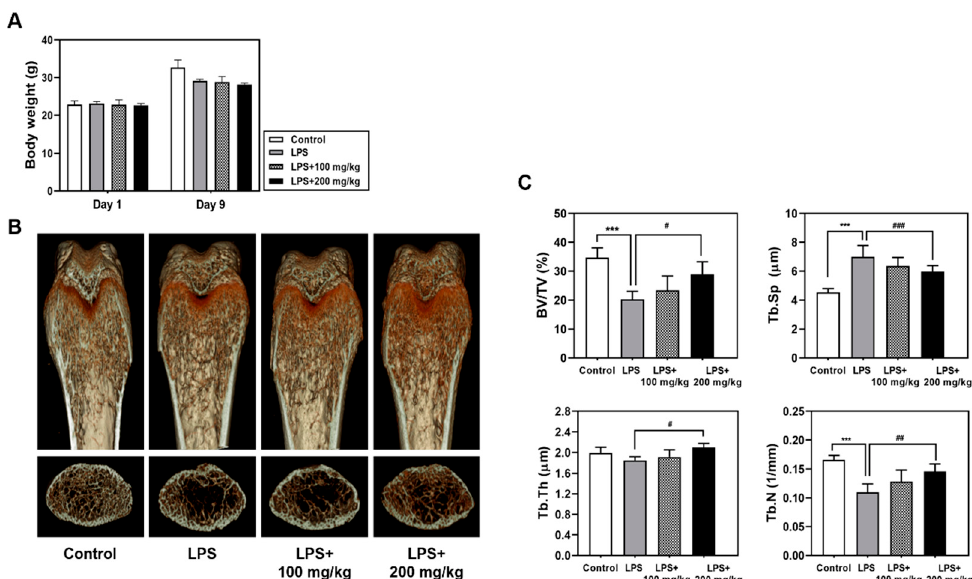
Figure 1. Vigeo attenuates lipopolysaccharide (LPS)-induced inflammatory bone loss. Mice were intraperitoneally injected with LPS (10 mg/kg) followed by treatment with indicated concentrations of Vigeo for 7 days. ( A ) Body weight measurement during the experimental period. ( B ) Representative three-dimensional micro-computed tomography (micro-CT) images of the coronal and transverse sections in the distal femurs of a mouse from each group. ( C ) Measurement of the trabecular morphometric parameters of bone volume/total volume (BV/TV), trabecular separation (Tb. Sp), trabecular thickness (Tb. Th), and trabecular number (Tb. N) in the proximal femurs using the micro-CT data using the INFINITT-Xelis software 1.16. Statistical analysis was performed using one-way analysis of variance (ANOVA) followed by Tukey’s posthoc test for comparisons among three groups. *** p < 0.01 versus the control group; # p < 0.05, ## p < 0.01, ### p < 0.001 versus the LPS group.